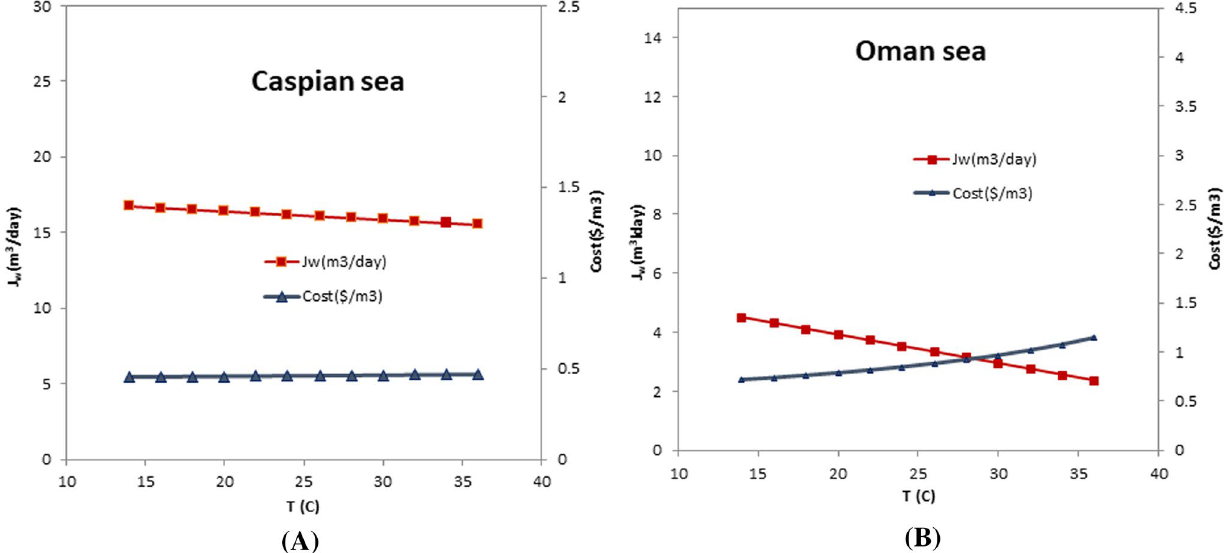
Fig.8 Evaluating the effect of the water temperature on the cost and the permeate flow rate (Δ P = 45 bar, R salinity Caspian = 17,000 mg/L, Feed salinity Oman = 36,000